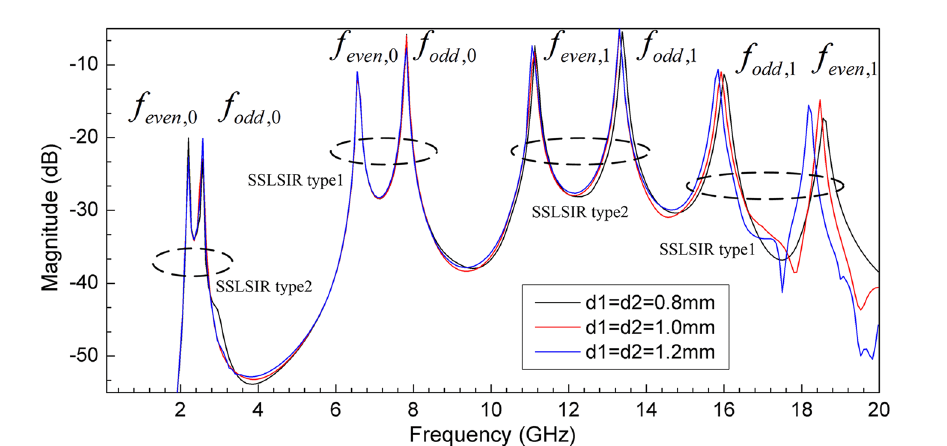
Figure 14. The mode distribution of the two types of SSLSIRs under different depth d1 and d2 of slit line.